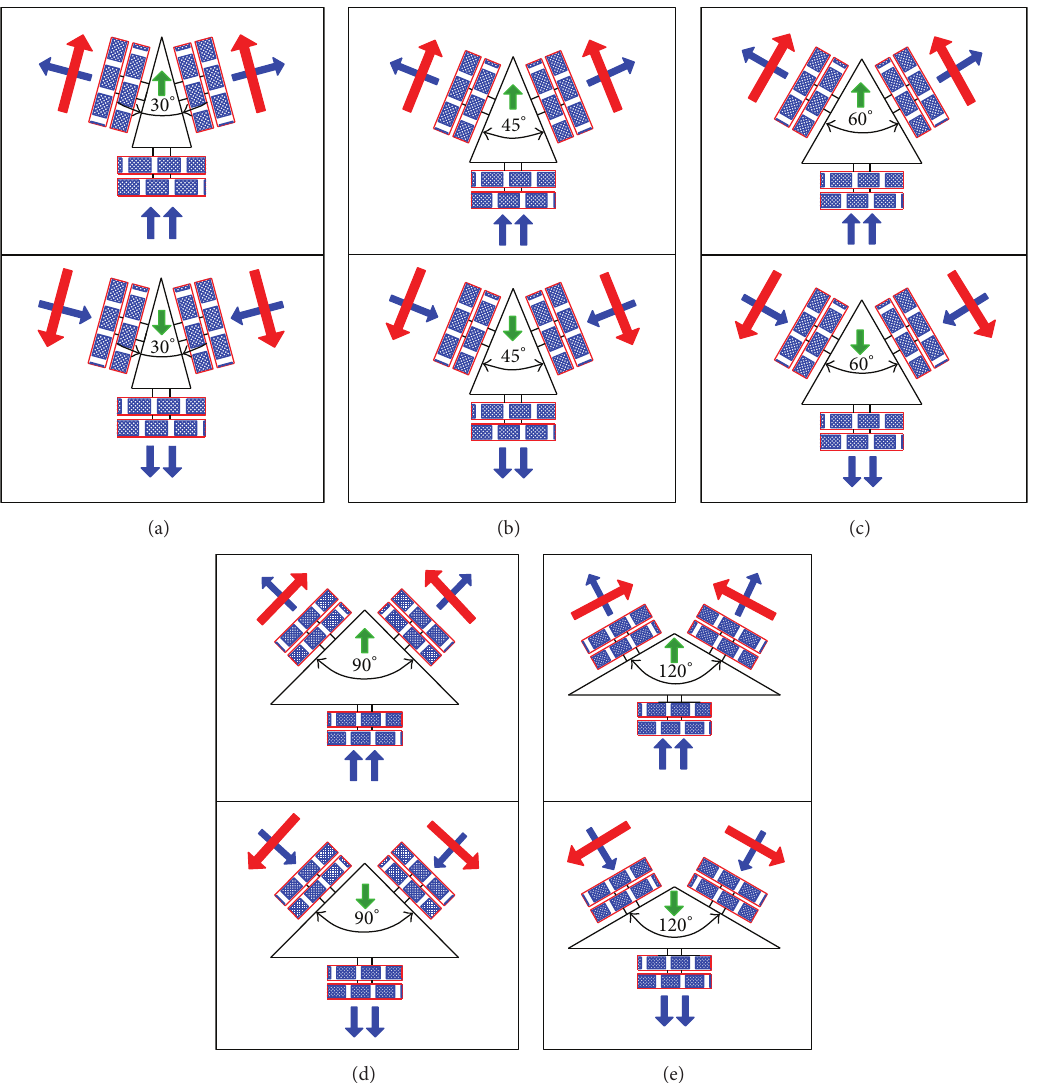
Figure 8: Front and back movement of TWOMR, wheel and roller rotations, when (a) 𝜃 = 30 ∘ , (b) 𝜃 = 45 ∘ , (c) 𝜃 = 60 ∘ , (d) 𝜃 = 90 ∘ , and (e) 𝜃 = 120 ∘